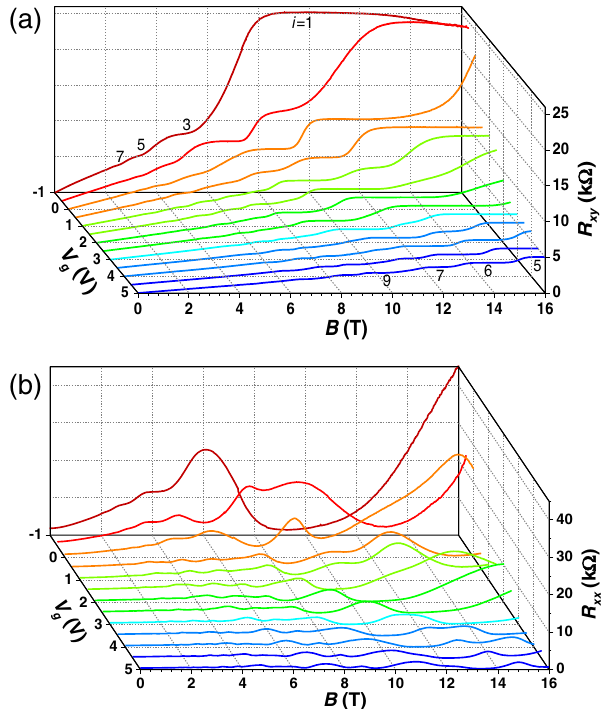
FIG. 1. Three-dimensional representation of (a) Hall resistance and (b) longitudinal magnetoresistance of a 70-nm-thick fully strained HgTe layer as a function of applied gate voltage V are taken at a nominal temperature of 20